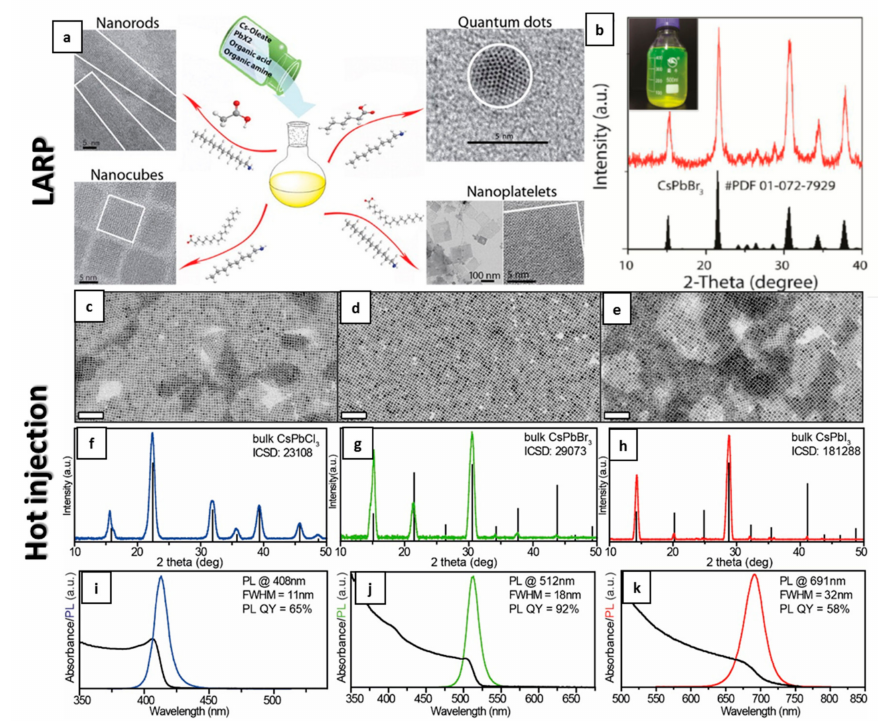
Figure 3. ( a , b ) CsPbX 3 NCs synthesized by LARP reproduced with permission from Ref. [19], Copyright (2016) American Chemical Society: ( a ) Bright field TEM image and ( b ) XRD pattern of CsPbX 3 NCs. ( c – k ) CsPbX 3 NCs synthesized by hot injection method reproduced with permission from Ref. [17], Copyright (2018) American Chemical Society. Bright field TEM images (scale bars are 100 nm in all images), XRD patterns of highly oriented NCs, along with absorption and PL spectra of CsPbCl 3 , CsPbBr 3 , and CsPbI 3 NCs